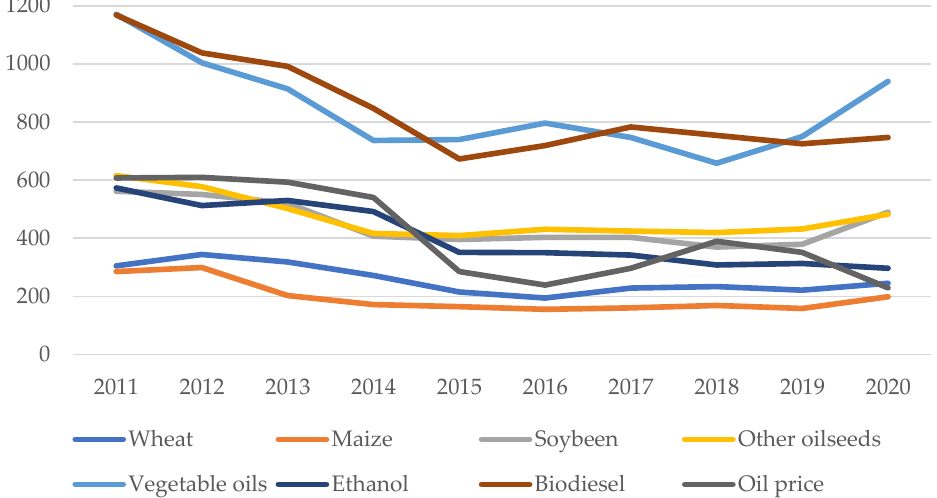
Figure 2. World market prices for ethanol, biodiesel, crude oil, and different feedstocks in USD/t2011–2020. Note: ethanol 1 liter = 0.783 kg, biodiesel 1 liter = 0.88 kg, 1 barrel is 0.138 metric tonnes and 158.98 liters. Source: authors’ composition based on